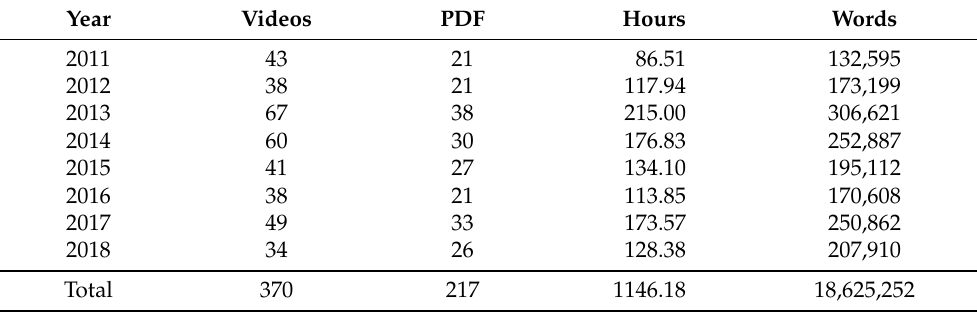
Table 1. Collected raw data